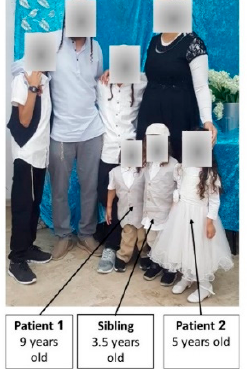
Figure 2. Height of patients 1 and 2, and their Picture 1. Height of patients 1 and 2, and their sibling. Picture 1. Height of patients 1 and 2, and their sibling.